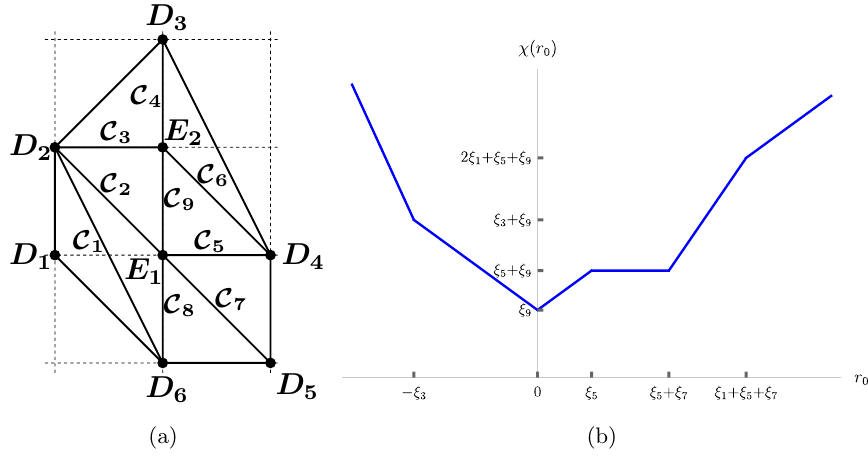
Figure 30 . Resolution (b) of the E 32 ; 1 singularity and its vertical